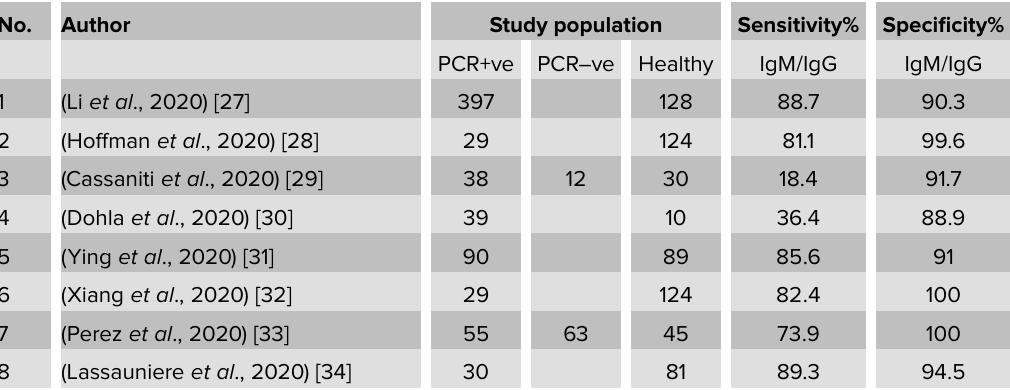
TABLE 1: Sensitivity and specificity of combined IgM/IgG rapid